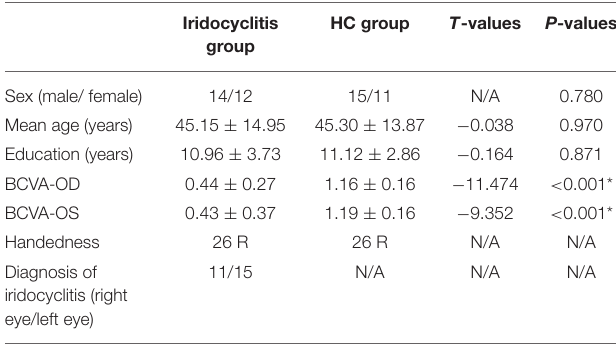
TABLE 1 | General clinical information of patients with iridocyclitis and healthy